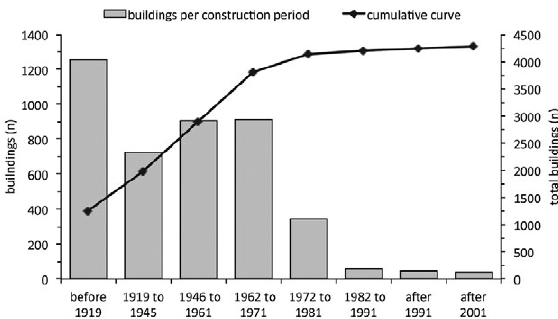
Fig. 9. Buildings of Rapallo per year of construction periods (from ISTAT census,